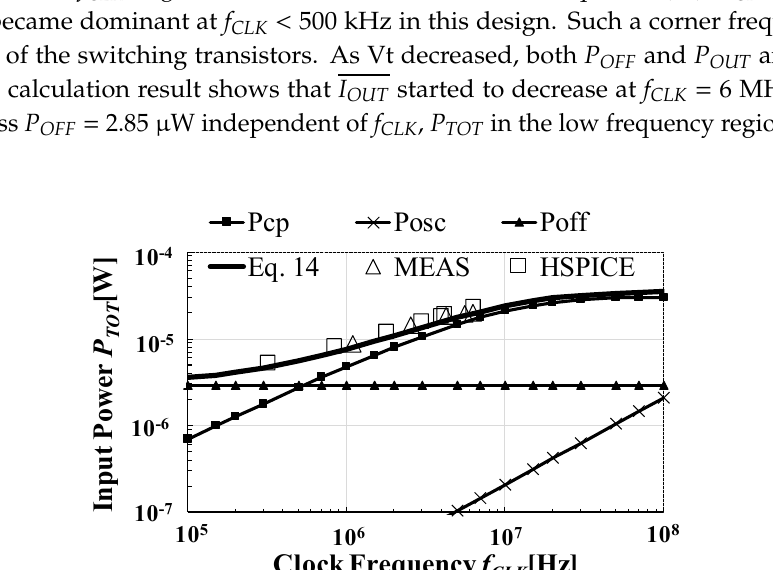
Figure 13. P TOT as a function of f CLK ( V DD = 0.5 V , V OUT = 2 V, f IN = 1 kHz).